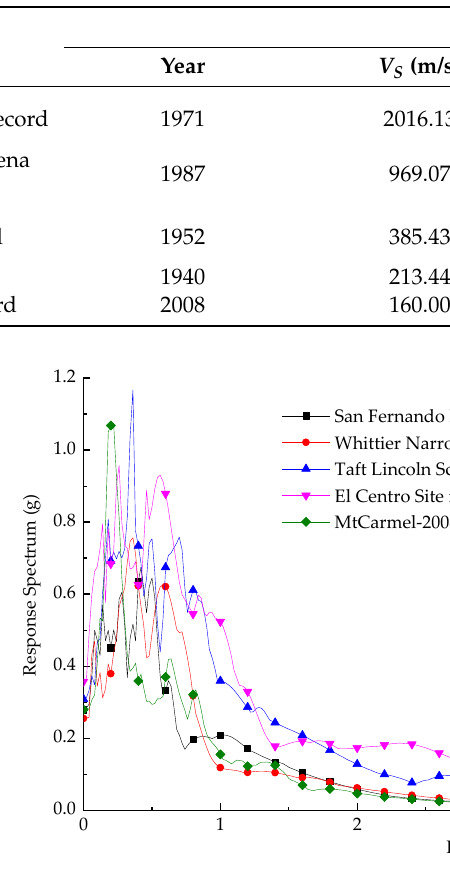
Table 2. Site classes of each record.